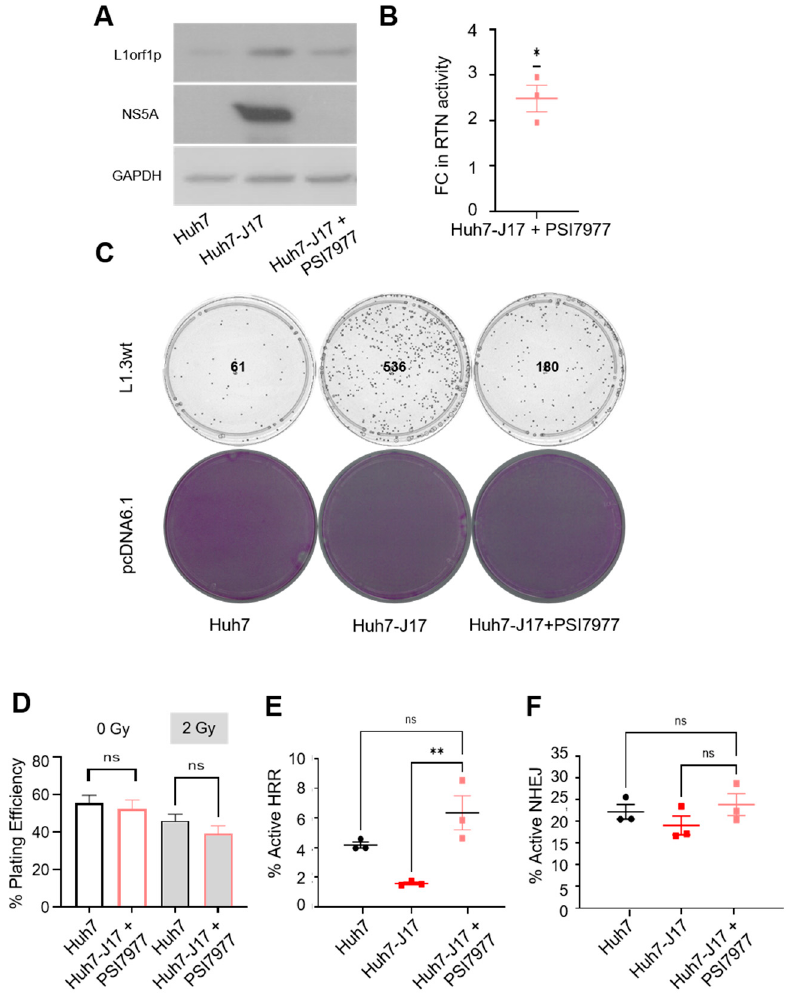
Figure 5. Influence of HCV on L1 retrotransposition continues even after viral clearance. Western blot analysis on whole cell lysates of indicated cells to confirm the clearance of Hepatits C Virus (HCV) replicon and the L1orf1p level 3 weeks after treatment with 10 µM PSI7977. Tubulin was used as a loading control ( A ). Graph represents the fold change (FC) in the number of colonies representing active retrotransposition (RTN) in Huh7-J17+PSI7977 cells compared to Huh7 cells ( B ). Plates showing retrotransposition rates in indicated cell lines as assessed via blasticidin-based selection of resistant colonies. Image is representative of 3 independent repeats. Numbers represent number of colonies in the plate ( C ). Plating efficiency (%) of the indicated cells when exposed to 2 Gy X-rays or not ( D ). Graphs showing the percentage of GFP-positive cells representing active HRR ( E ) and NHEJ ( F ) repair in the indicated cell lines. ns = non-significant ( p > 0.05), * p < 0.05, ** p < 0.01 by one-sample t -test ( B ), unpaired t -test ( D ) and one-way ANOVA ( E , F ). Detailed information about the Western blotting can be found in Figure S7. Key: L1orf1p = L1 open reading frame encoded protein; NS5A = nonstructural protein 5A; GAPDH = Glyceraldehyde 3-phosphate